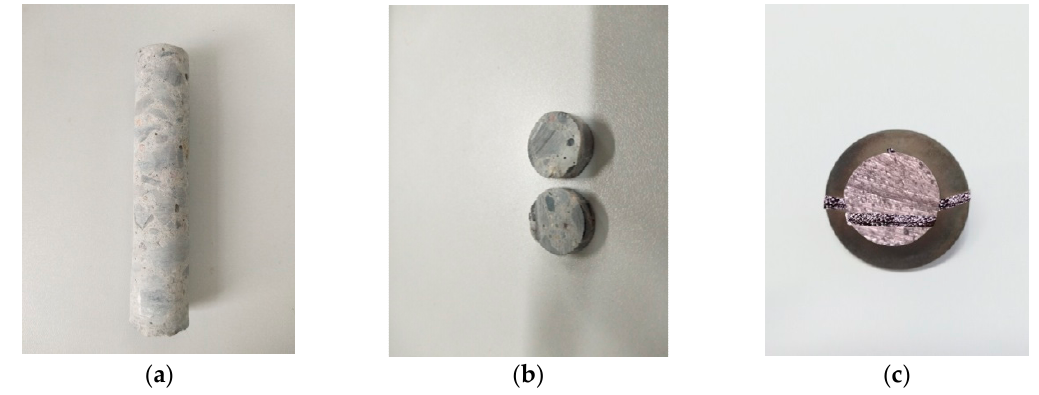
Figure 2. Sampling process: ( a ) drill core sample; ( b ) cut slice; ( c ) spray gold .